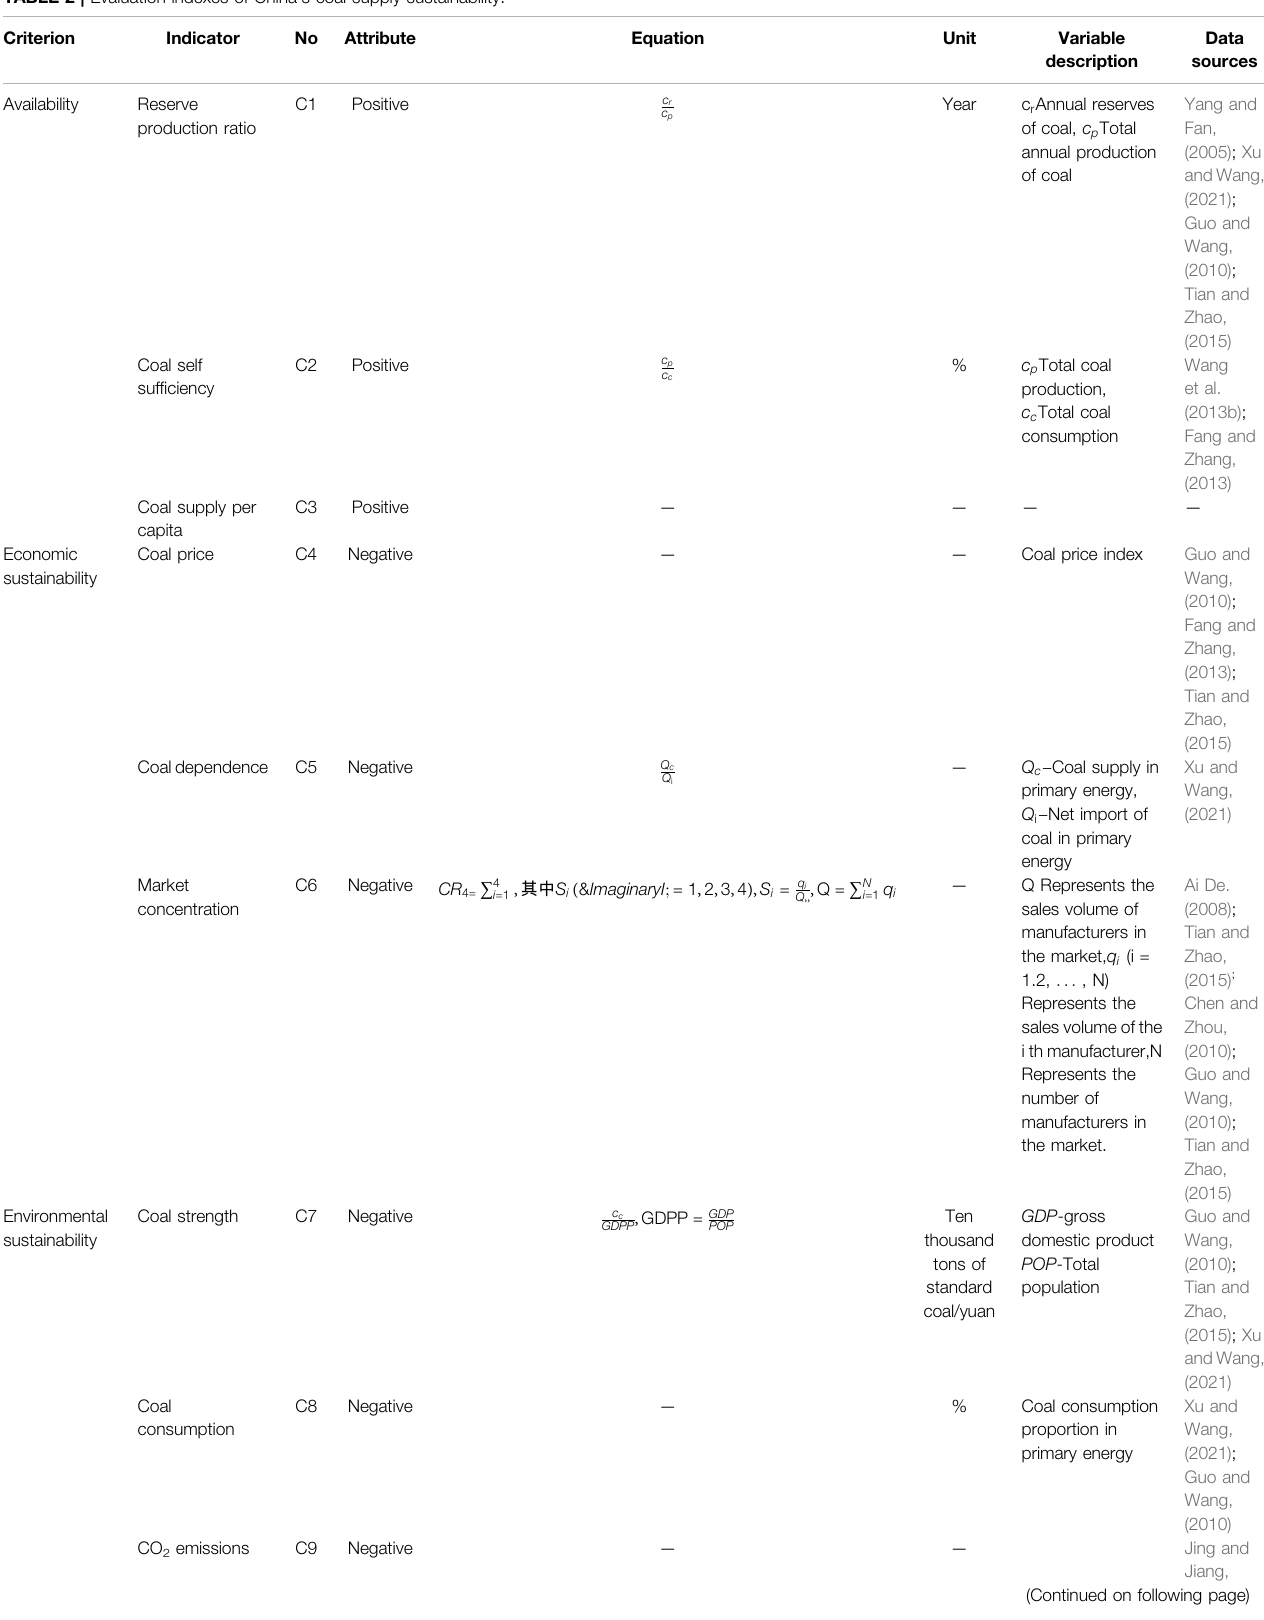
TABLE 2 | Evaluation indexes of China ’ s coal supply